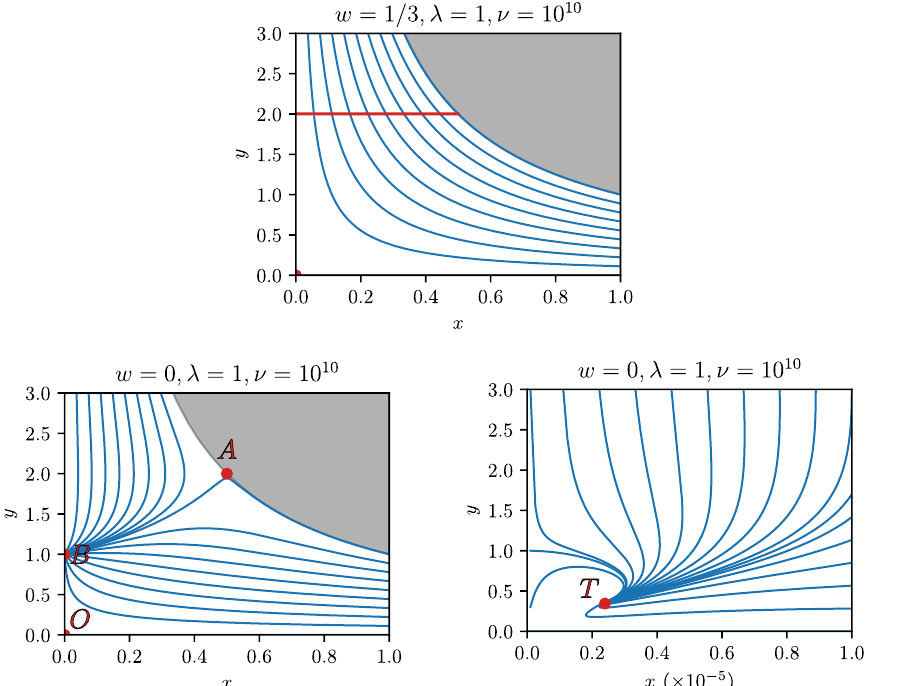
Figure 1 . The phase space of (3.4)–(3.5) with ν = 10 10 , λ = 1 , w = 1 / 3 (top) w = 0 (bottom). The right panel in the bottom is a zoom on the left one for small x . Fixed points are indicated and labeled as in table 1. The shaded region is the one excluded by the positive energy constraint Ω φ < 1